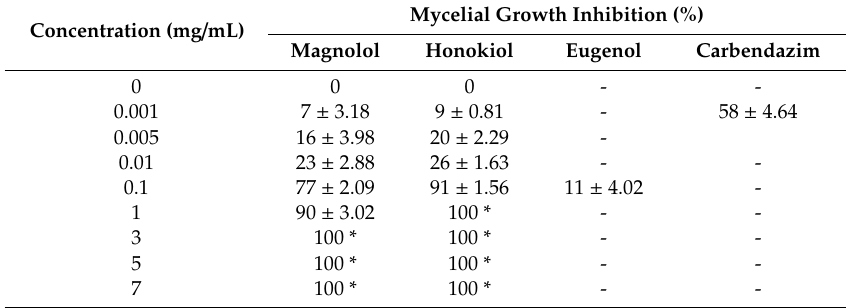
Table 1. Inhibition of magnolol and honokiol at the di ff erent concentration on mycelial growth of A. alternata